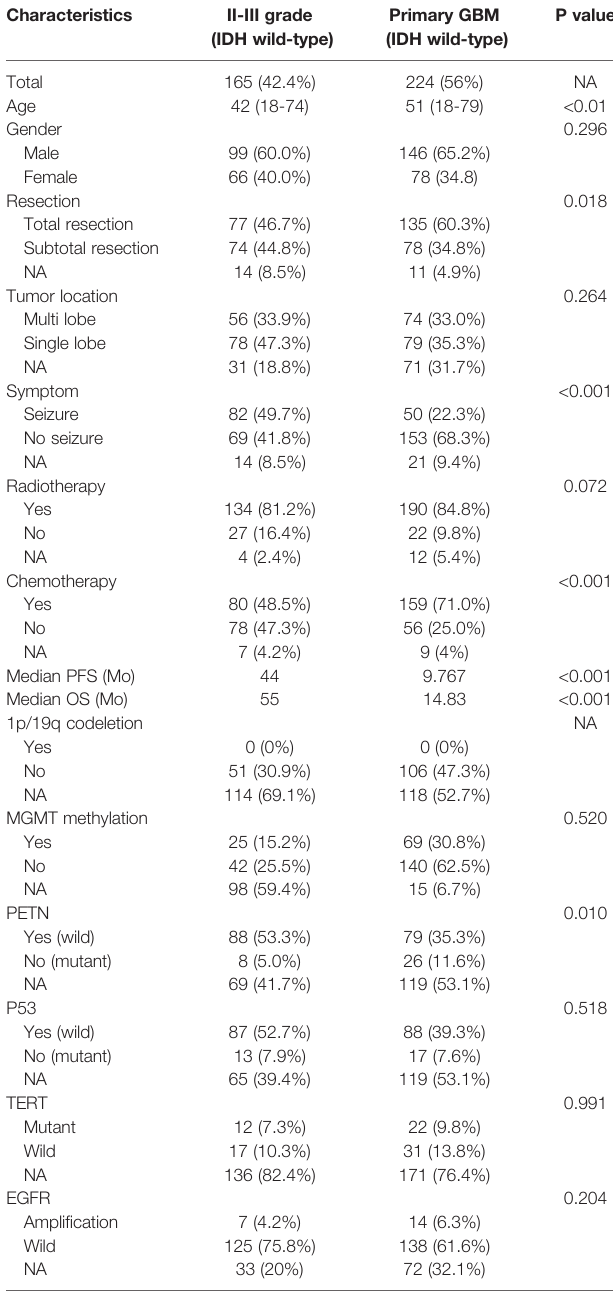
TABLE 1 | Characteristics of clinical and molecular in this